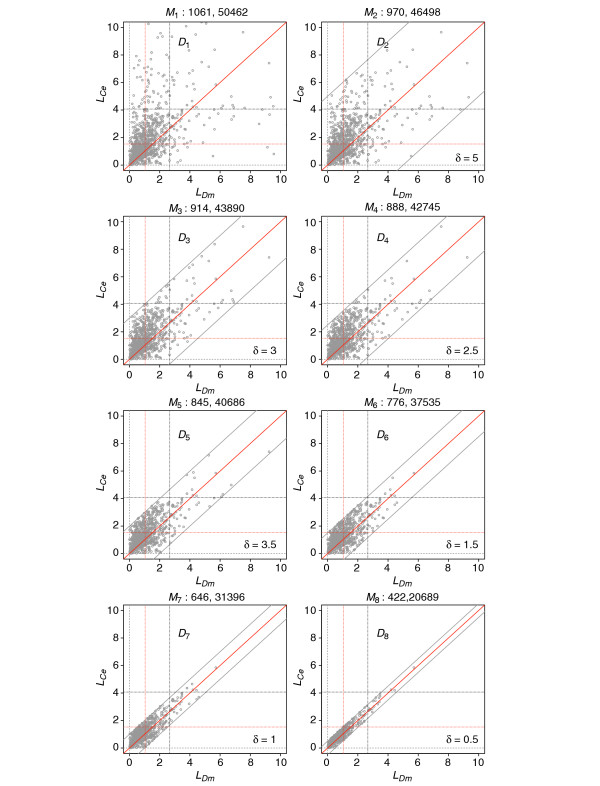
Description of the dataset. Di datasets are arranged according to a gradual decrease in the parameter δ. δ controls the inclusion of each homologous exon sequence in the dataset by defining margins above and below (y = x ± δ) a diagonal line (y = x) that constrains clock-like behavior in the evolution of C. elegans and D. melanogaster sequences. LCe and LDm are the respective relative branch lengths of C. elegans and D. melanogaster using H. sapiens as reference. Comma-separated values represent the number of homologous sequences and characters aligned in the Mi concatenated matrix. Di contains all the sequences without any constraint of evolutionary rates. Dotted black and red lines represent mean ,  and median values, respectively.